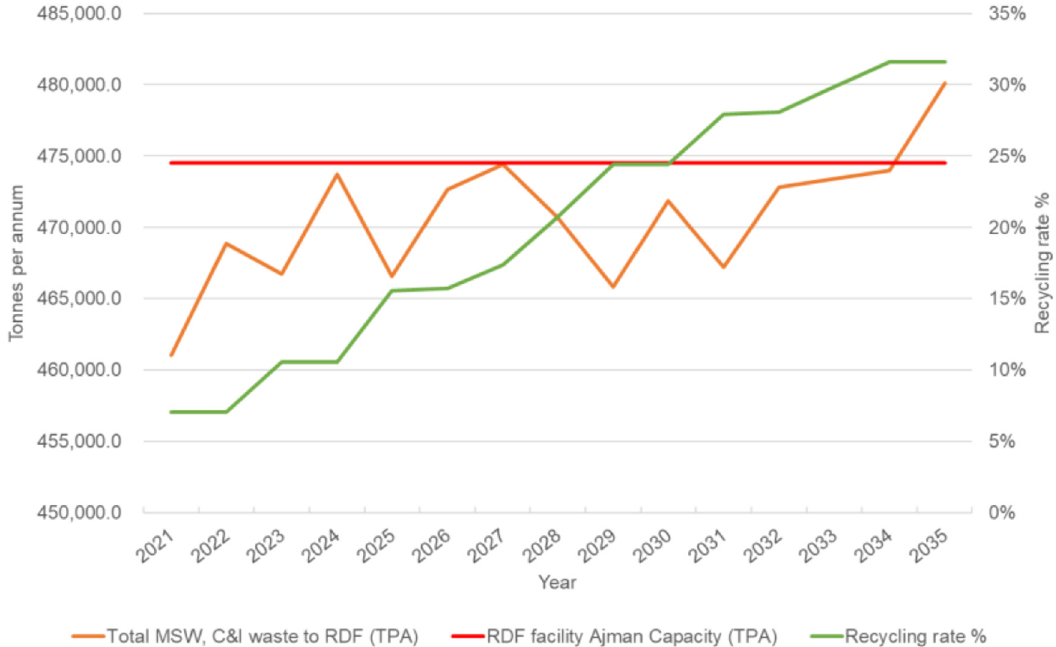
Fig. 9. The recommended approach to waste management in Ajman